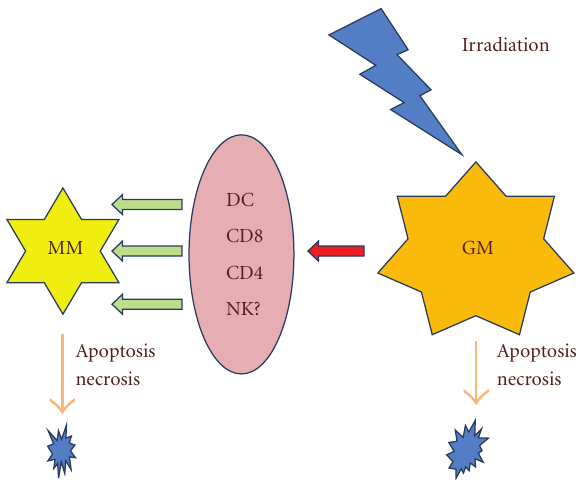
Figure 1: Relationship between the abscopal e ff ect and disappear- ance of micrometastases. Abbreviations: GM: gross metastasis, DC: dendritic cell, NK: natural killer cell, MM: